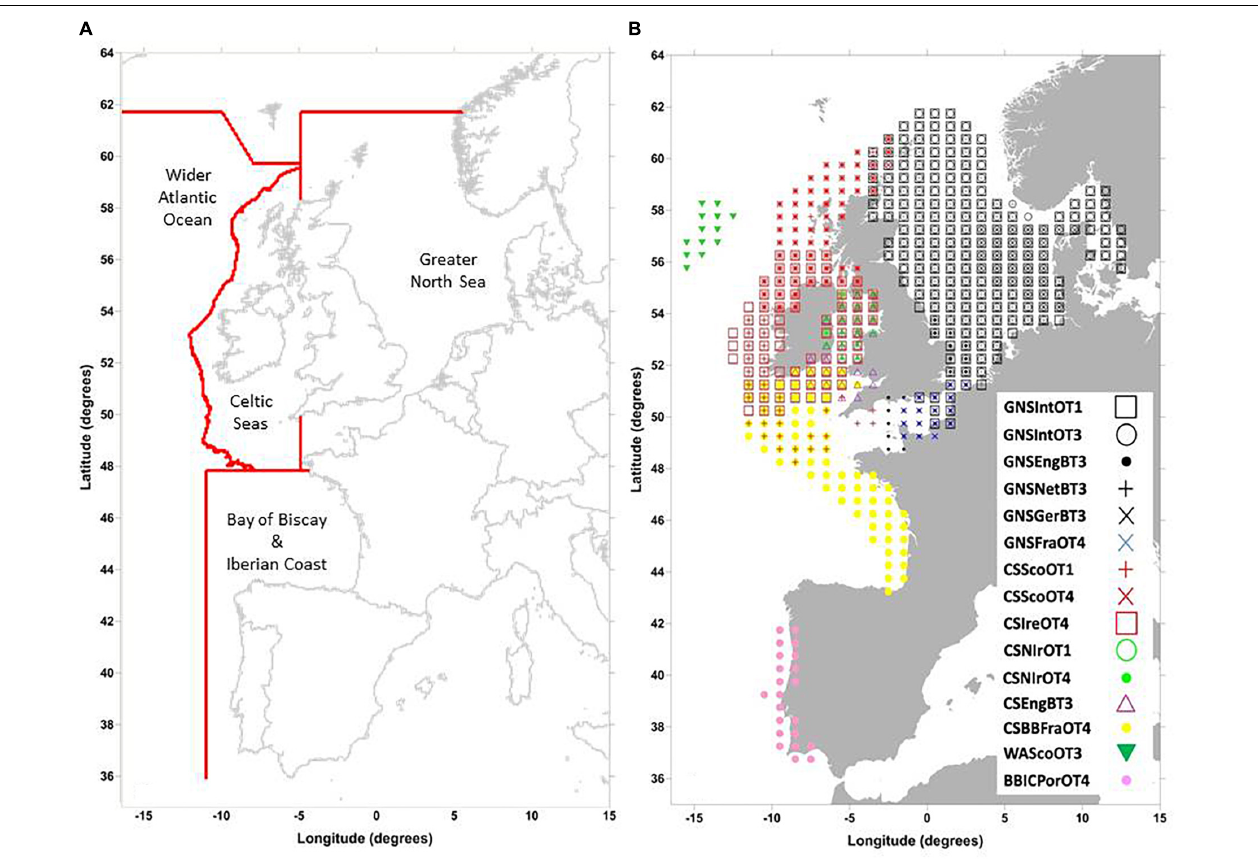
FIGURE 1 | (A) The sub-regions of the North-east Atlantic Ocean Region; The Greater North Sea (including the Kattegat and English Channel), the Celtic Seas, the Bay of Biscay and Iberian Coast, and the Wider Atlantic Ocean (Shapefile source: OSPAR website). (B) Survey coverage of the 15 published datasets across the Northeast Atlantic See Table 1 for explanation of survey